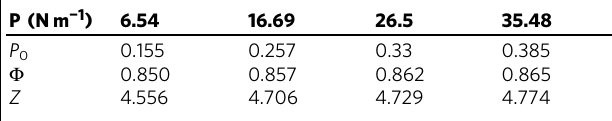
The corresponding dimensionless pressure P 0 determined according to the standard procedure described in the literature (see, e.g., ref. 40 ). So the re-scaled pressure P 0 is de fi ned as P /( k n D α − d ),where k n is the normal spring constant, D is the average diameter, α is the power exponent of the potential vs. deformation, and d is the dimension. The last two rows show